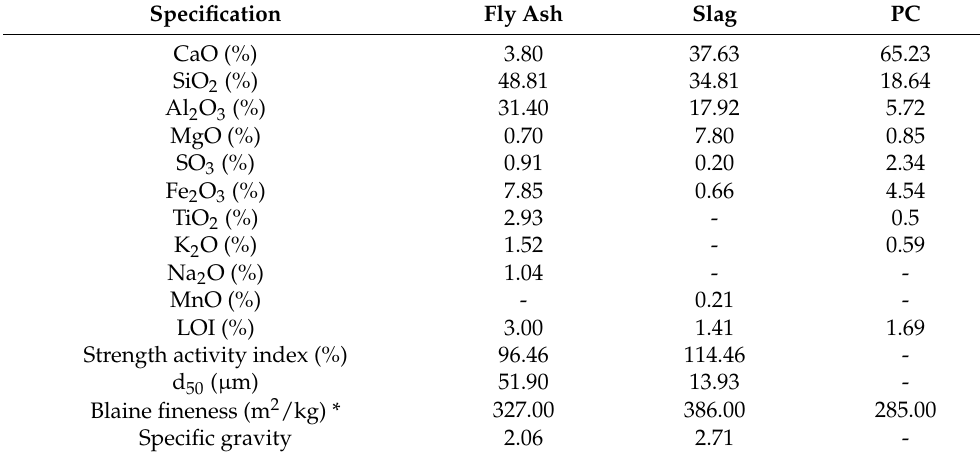
Table 1. Specifications of